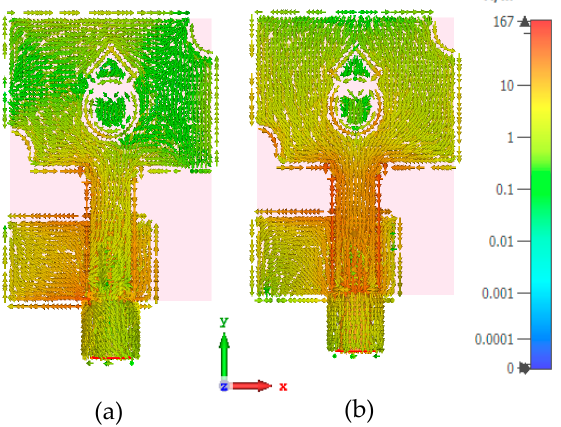
Figure 6. Current distribution at ( a ) 4 GHz, ( b ) 10 GHz.